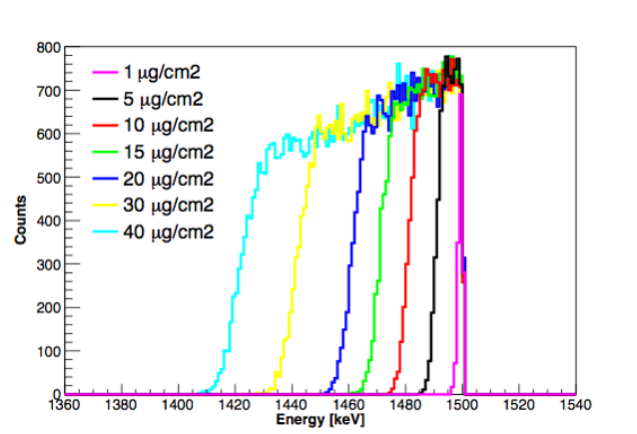
Figure 7: Energy spectrum of α which induce the reaction inside target with di ff erent target